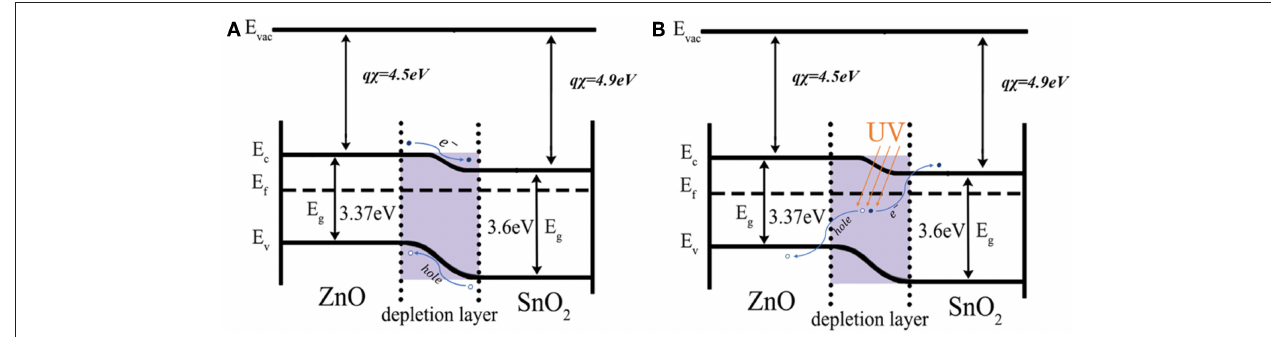
FIGURE 10 | Electron transfer between the formed SnO 2 /ZnO nanofiber heterojunctions (A) in dark and (B) under UV.